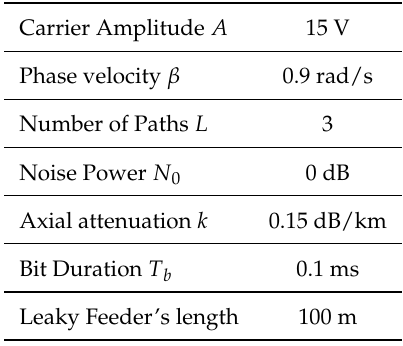
Table 1. Parameters used in the simulation